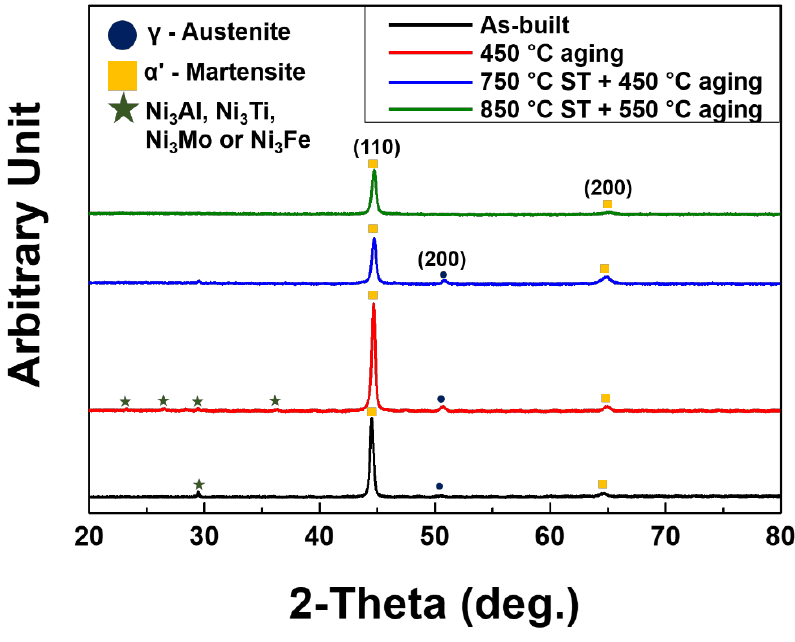
Figure 8. X-ray di ff raction (XRD) patterns of as-built and heat-treated maraging steel samples fabricated Figure 8. X-ray diffraction (XRD) patterns of as-built and heat-treated maraging steel samples by fabricated by SLM.